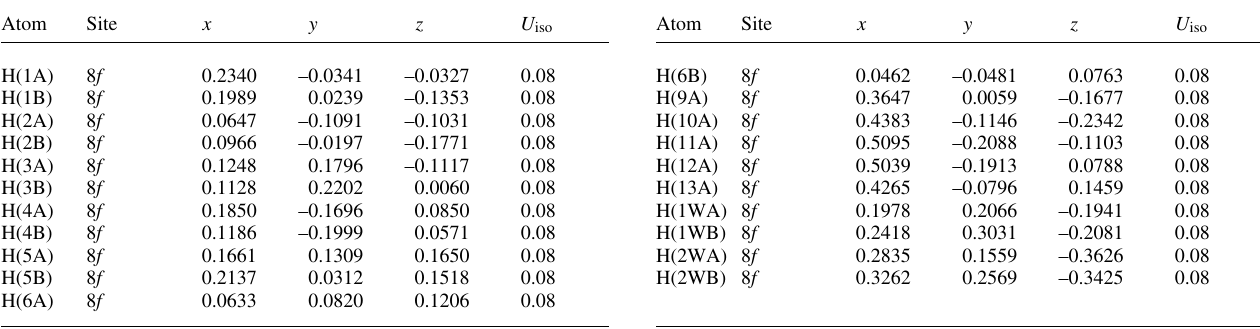
Table 2. Atomic coordinates and displacement parameters (in Å 2 )